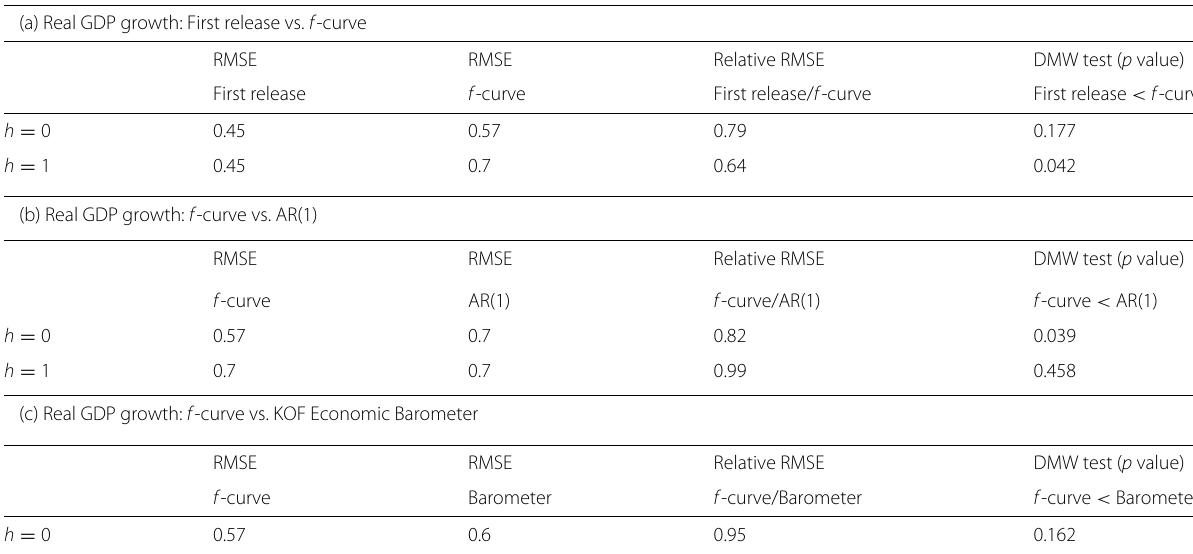
Table 1 Pseudo-real-time evaluation. Root-mean-squared errors (RMSE) for forecasts on days with a new quarterly GDP release. A lower RMSE implies higher predictive accuracy. h = 0 ( h = 1) denotes the forecast for the current (next) quarter. We use three benchmarks. First, we use the first quarterly release of the corresponding quarter (panel a). Second, we use an AR(1) model (panel b). Third, we use the KOF Economic Barometer (panel c). The Diebold-Mariano-West (DMW) test provides a p value for the null hypothesis of equal predictive accuracy against the alternative written in the column header (Diebold and Mariano 2002; West 1996). We assume a quadratic loss